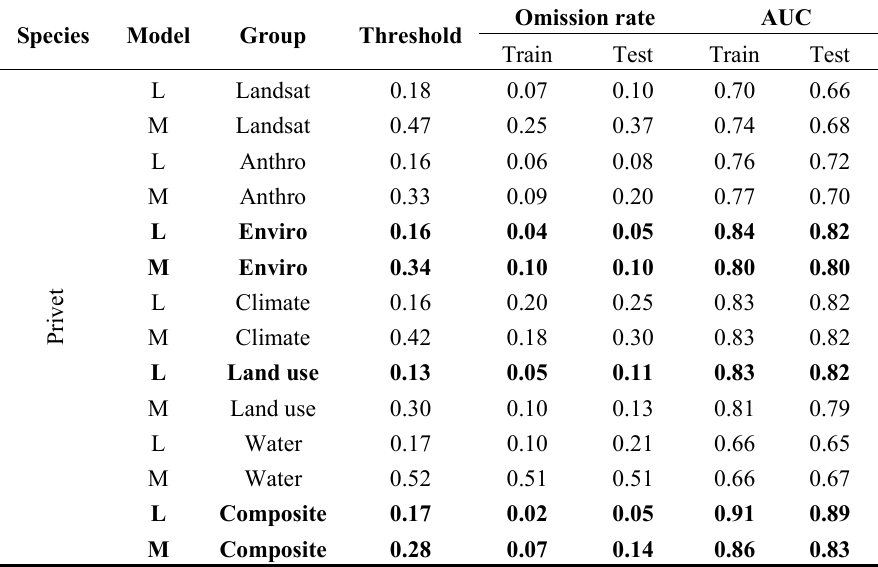
Table 3. Threshold (defined as maximum sensitivity plus specificity) and accuracy assessment for the three species (bold denotes strong models with AUC >0.80 and omission rate <0.20) using logistic regression (L) and MaxEnt (M). The variables were grouped into four groups: Landsat, Anthropogenic (Anthro), Environmental (Enviro) and Climate. The composite model is the final, best